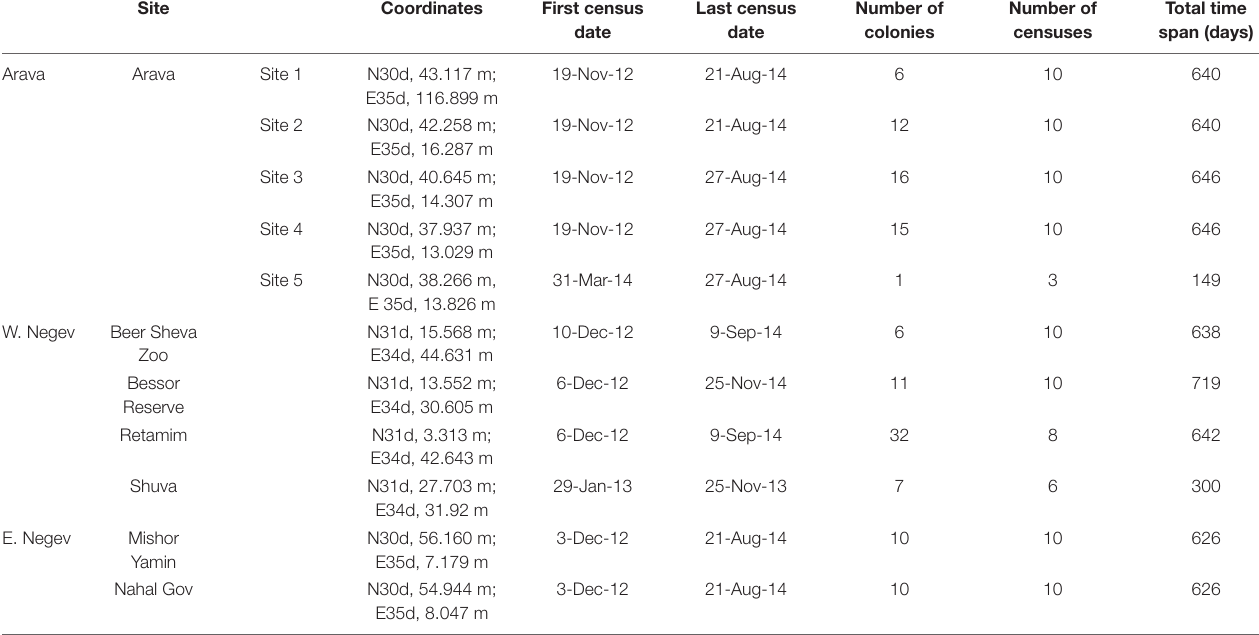
TABLE 1 | Census locations, total observation times, and number of colonies observed by site and region.